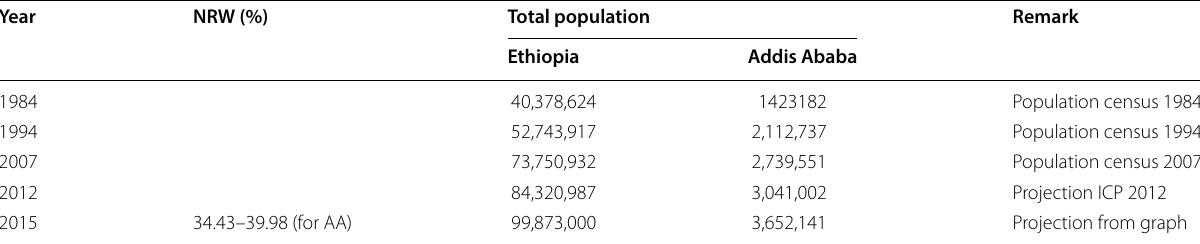
Table 1 Performance indicator of population